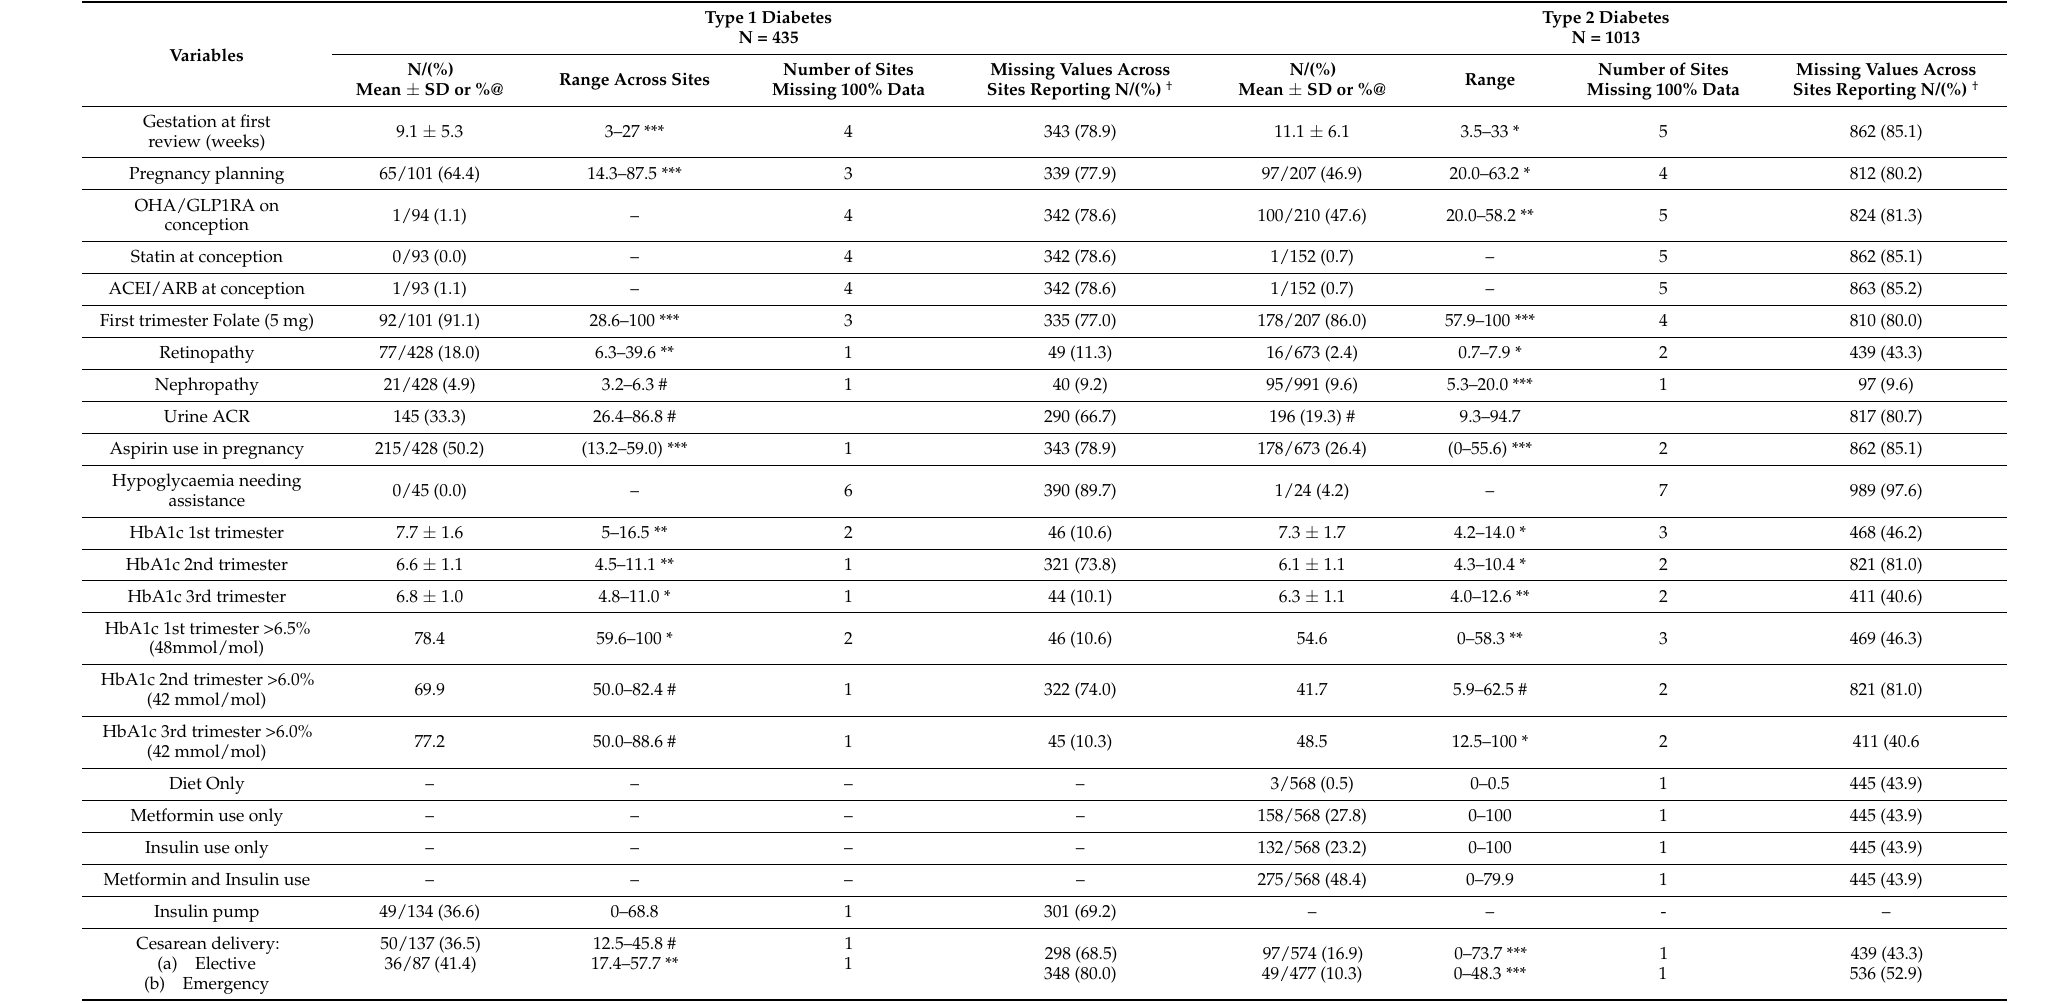
Table 5. Pregnancy care and obstetric outcomes of women with pre-existing